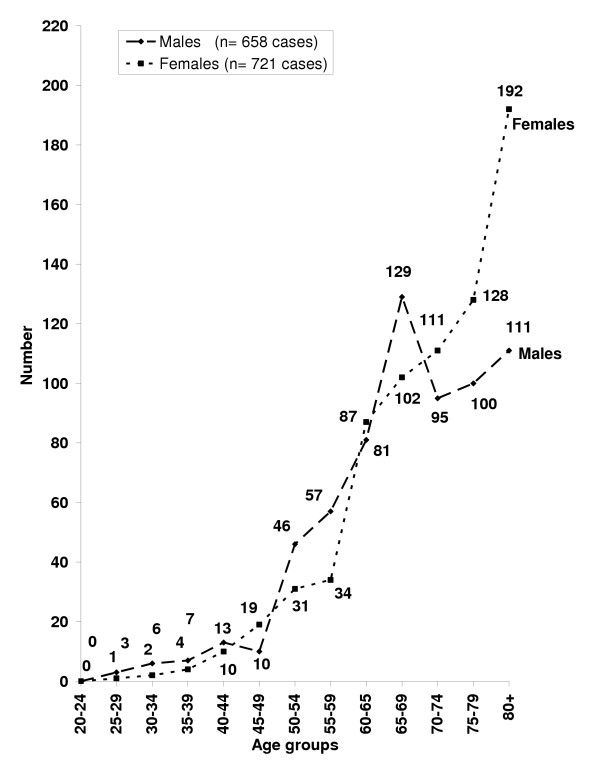
Age-distribution of the invasive colonic adenocarcinomas (n = 1379 cases); 1988–1998.